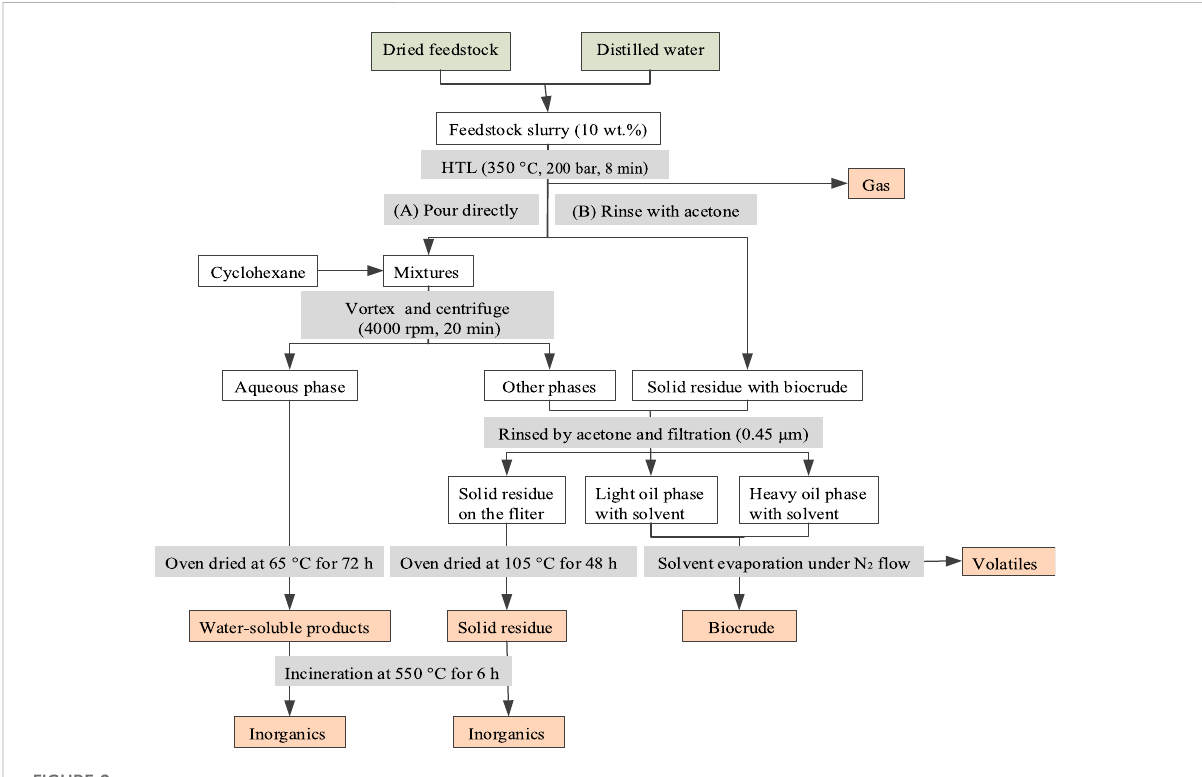
FIGURE 2 Flow chart of procedures for product separation and extraction from continuous and batch HTL